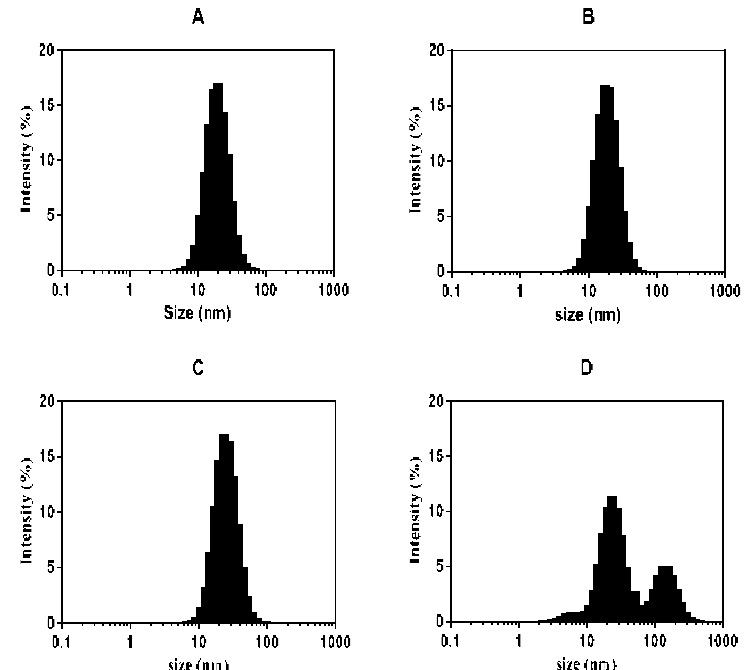
Fig. 5. Size distribution based on light scattering intensity (%) of gold nanoparticles samples that synthesized at: A) 95 °C, B) 80 °C, C) 70 °C and D) 50 °C temperatures,